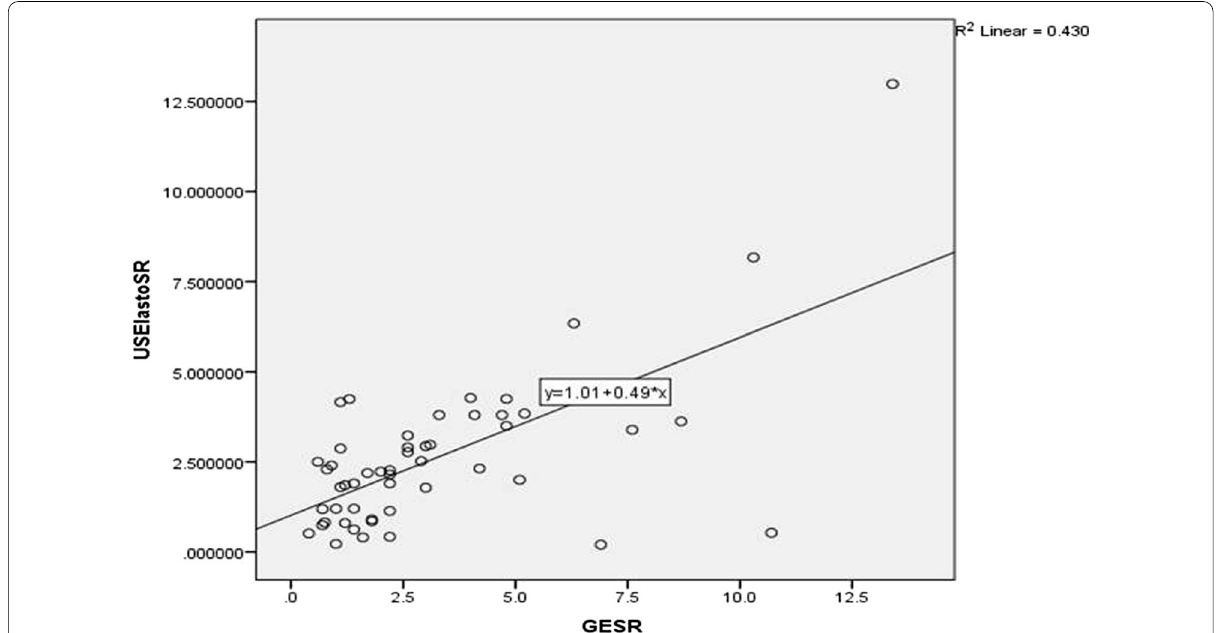
Fig. 1 Moderate correlation between the SR calculated by the conventional elastography software and AI-enabled elastography